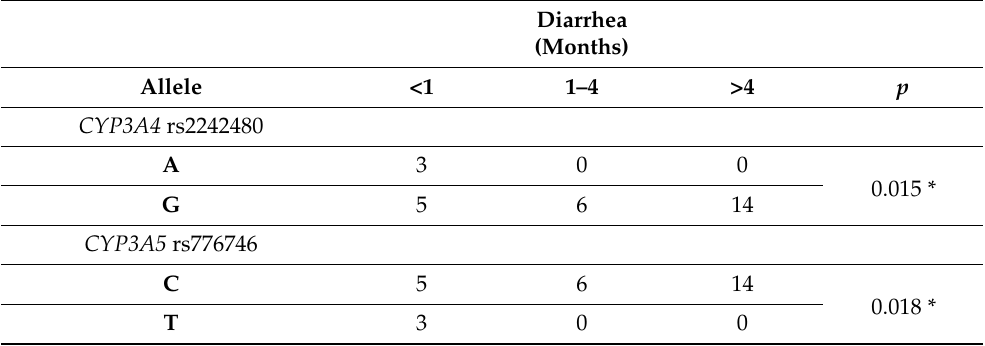
Table 5. Association between the G allele ( CYP3A4 rs2242480) and the C allele ( CYP3A5 rs776746) with months of persistence of the maximum grade of diarrhea.